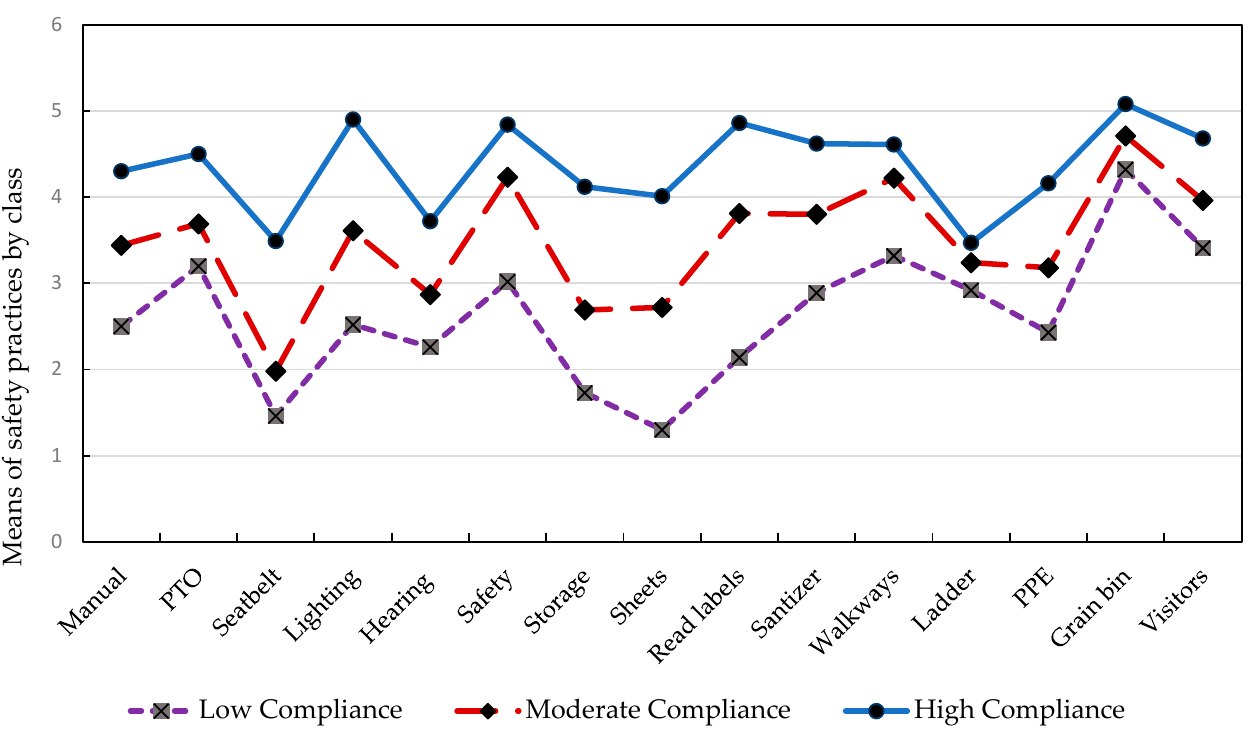
Figure 3. Self-reported compliance with 15 safety practices in low, moderate, and high safety level groups in 326 farm and ranch operators in 7 Midwest states,